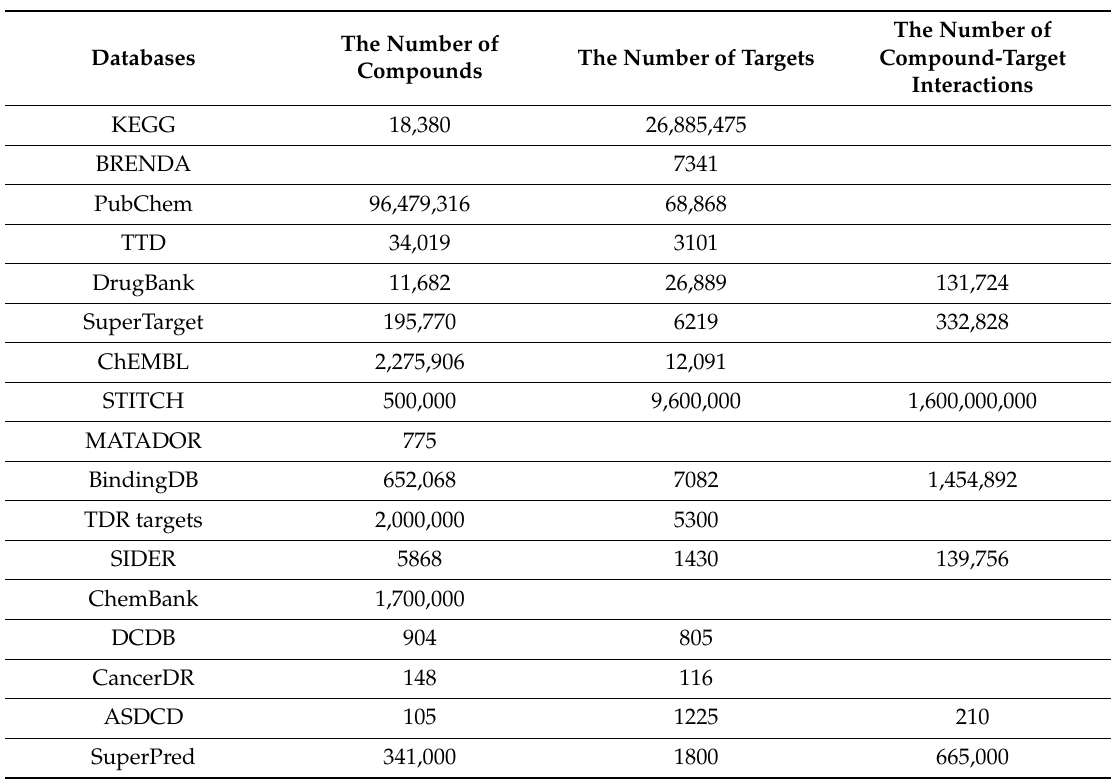
Table 2. The statistics of the number of compounds, targets and compound-target interactions in the databases covered in the